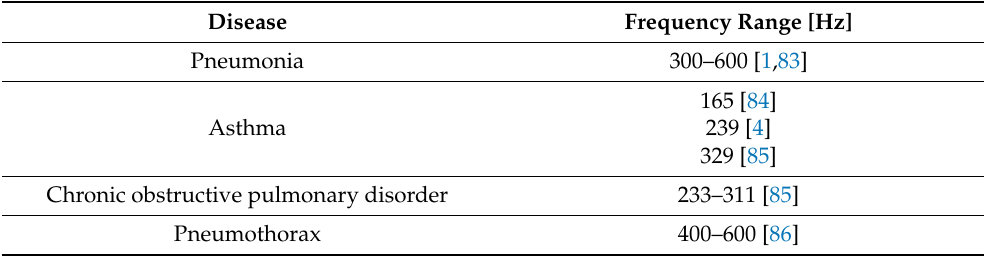
Table 1. Frequency signatures of respiratory